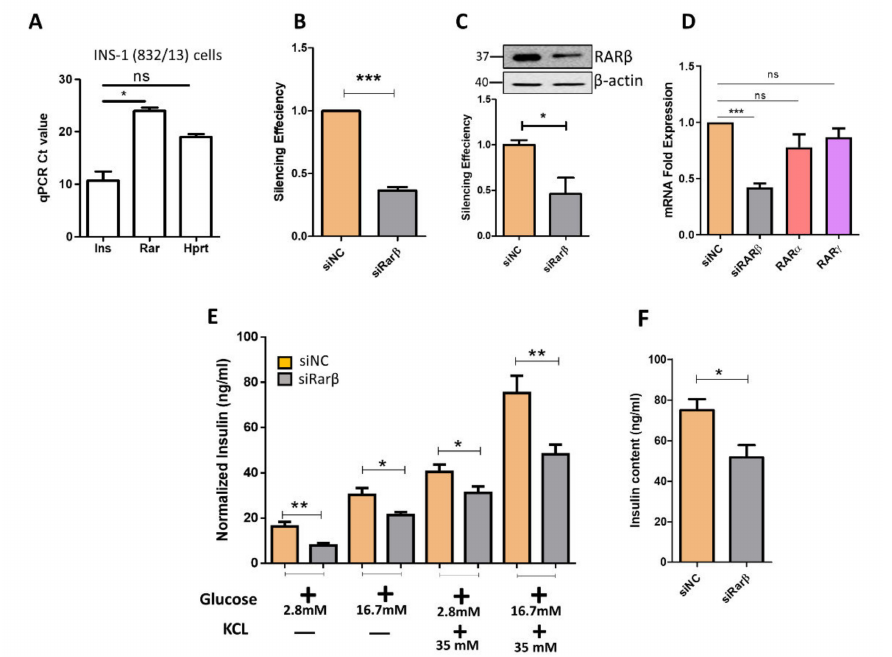
Figure 2. Impact of Rar β silencing on insulin secretion. ( A ) qPCR expression analysis of Rar β and Insulin genes ( Ins ) in INS-1 cells. ( B ) Silencing efficiency of Rar β mRNA expression 48 h